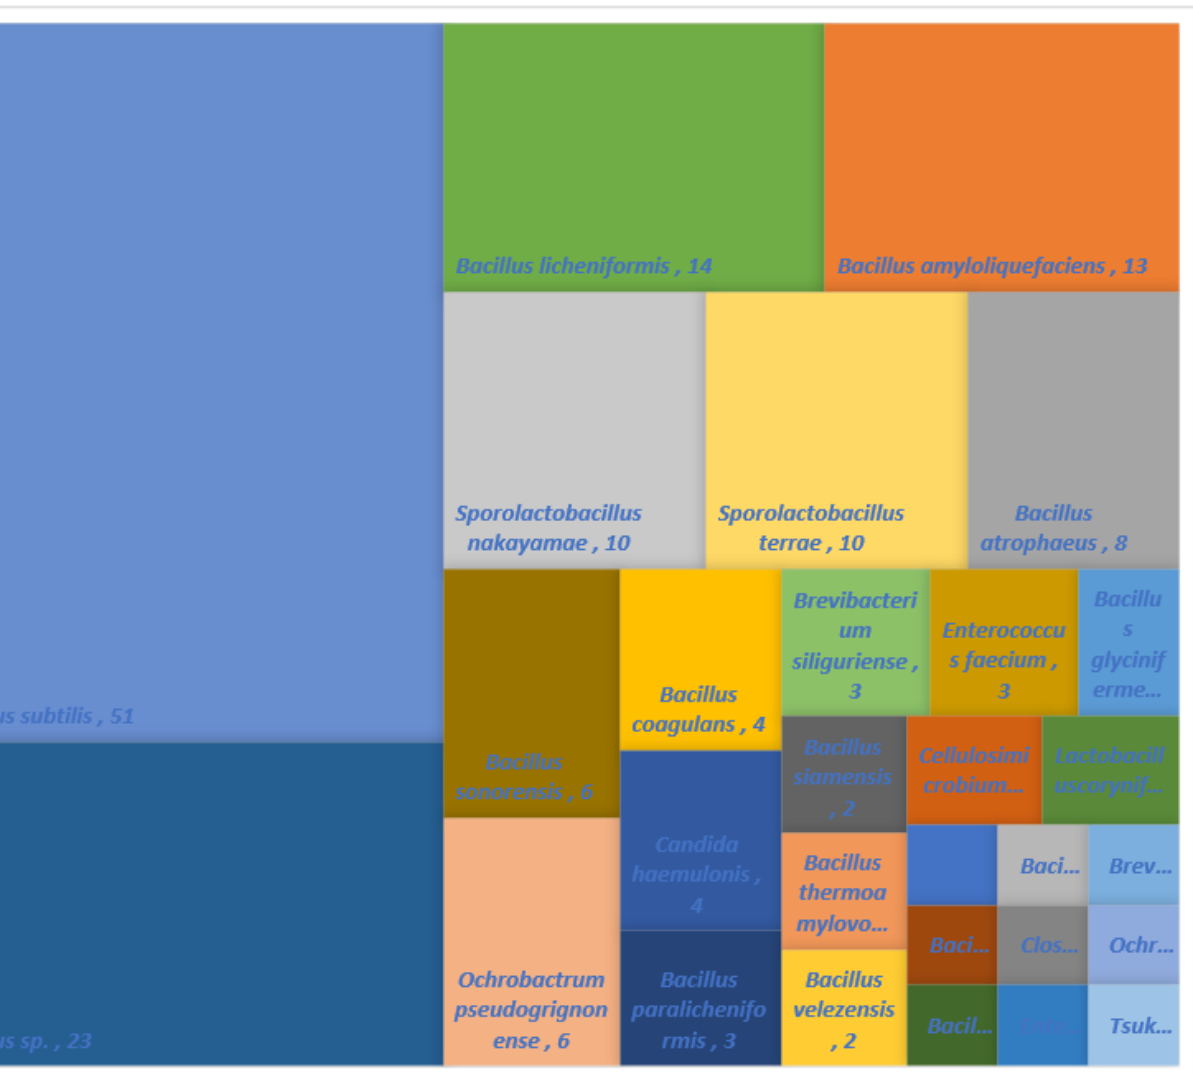
Figure 2. Ratio of screened strains from Doenjang based on 16S rRNA. Based on the 16S rRNA sequencing of the isolates used in this study, fifty-one, twenty- three, thirteen, fourteen, ten, and ten isolates belonging to the species of Bacillus subtilis